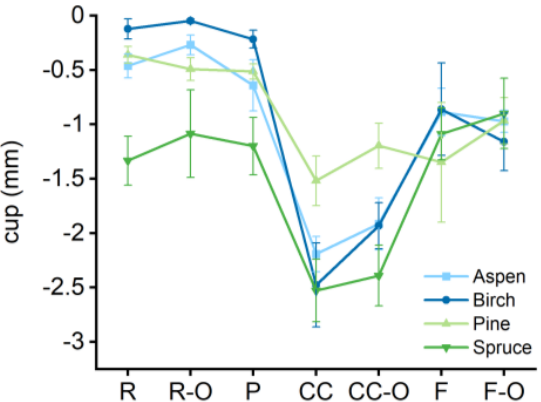
Figure 5. Cupping of aspen, birch, pine, and spruce due to water vapor sorption measured from ◦ modified face after conditioning at 95% RH, 20 °C. modified face after conditioning at 95% RH, 20